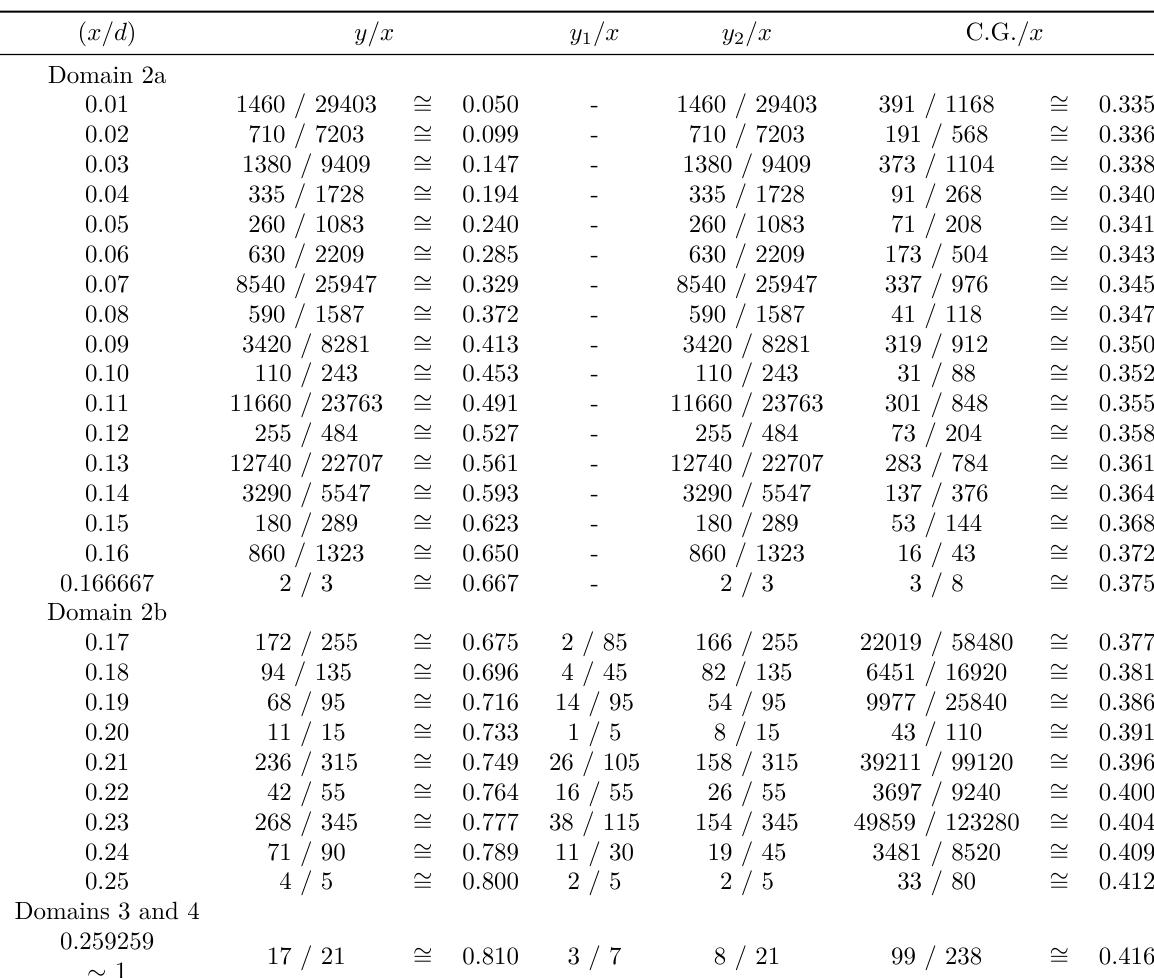
Table 1. Section properties in the ultimate limit state (Domains 2, 3 and